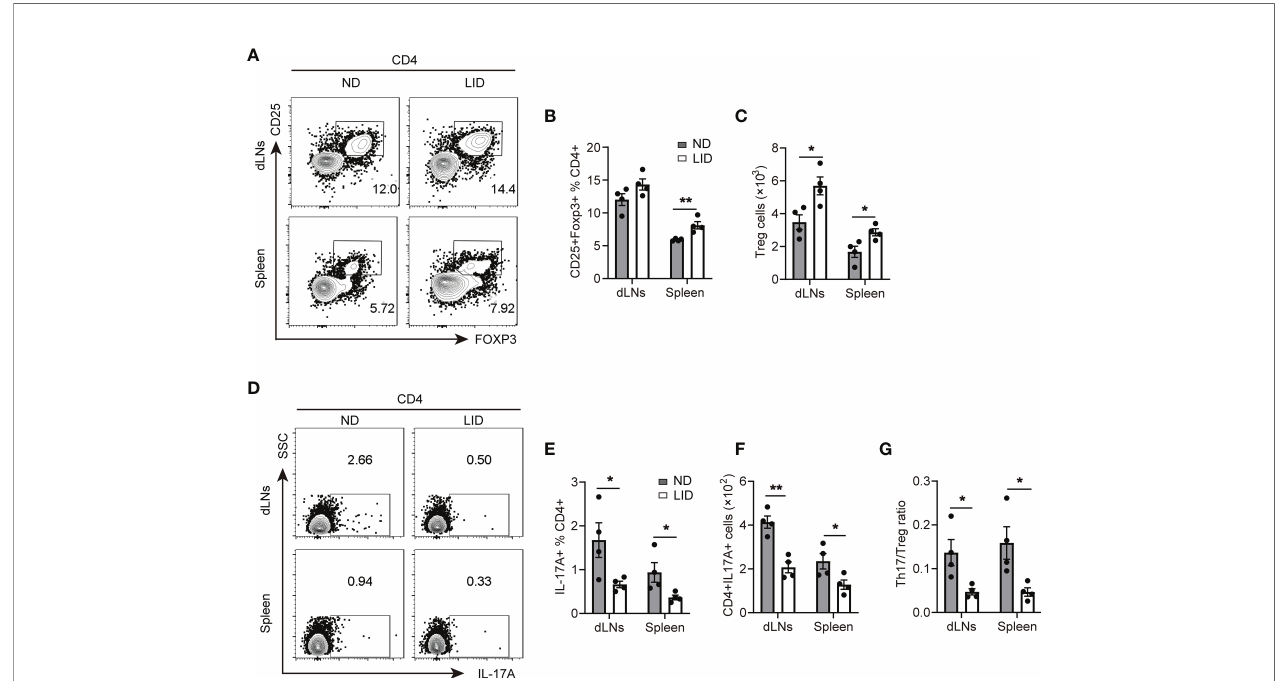
FIGURE 3 | Insuf fi cient iron promotes Treg cell expansion in pristane-induced lupus. 8-weeks old female mice were i.p. injected with 500 m l pristane and fed with ND or LID for 6 months. After 6-months of pristane stimulation, mice were sacri fi ced for analysis. (A) Representative fl ow cytometry of Treg cells gated CD4 + T cells in dLNs and spleen of the ND- and LID-treated mice. (B, C) Quanti fi cation of the frequency and numbers of the Treg cells in (A) . (D) Representative fl ow cytometry of Th17 cells gated on CD4 + T cells in dLNs and spleen of the ND- and LID-treated mice. (E, F) Quanti fi cation of the frequency and numbers of Th17 cells in (D) . (G) Quanti fi cation of the ratio of Th17 cells and Treg cells in (B , E) . **P < 0.01, *P < 0.05 (unpaired two-tailed Student ’ s t -test for B, C , E – G ). Data are shown as mean ± S.E.M. Two independent experiments were performed, n = 4.